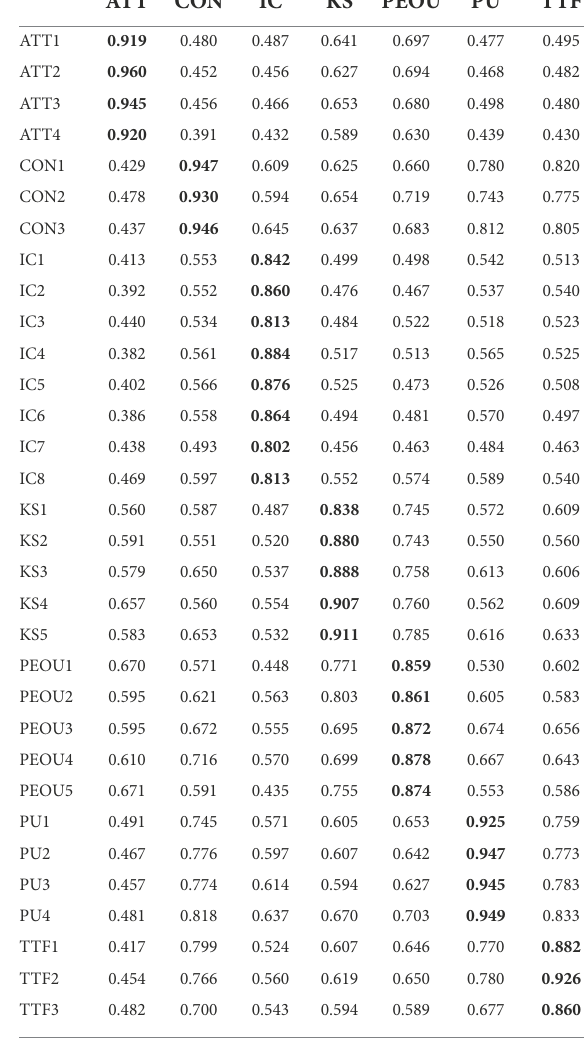
TABLE 3 Results of confirmatory factor analysis, validity analysis, and reliability test.